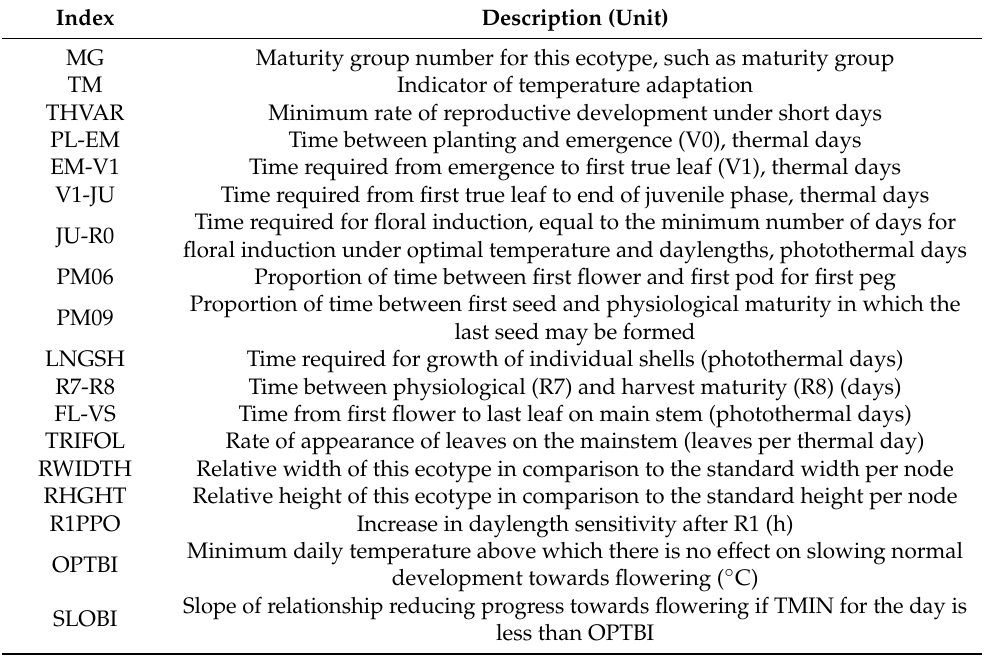
Table 3. Ecotype coefficients of bell pepper in